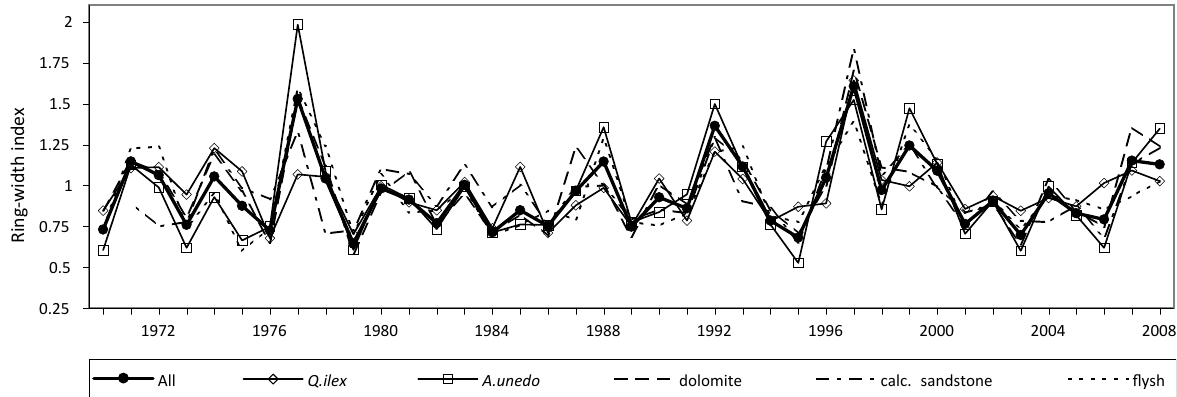
Fig. 5. Normalized and detrended average ring width